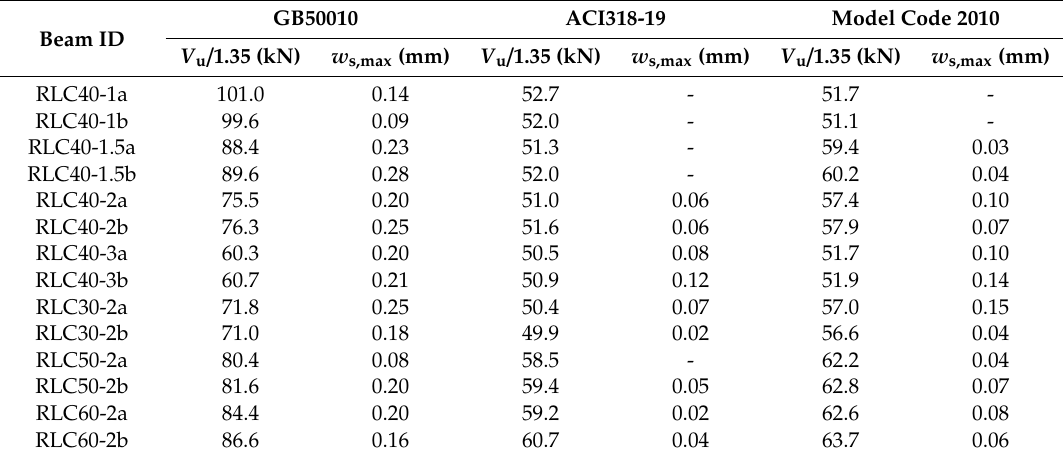
Table 5. Maximum width of diagonal cracks on test beams at normal service